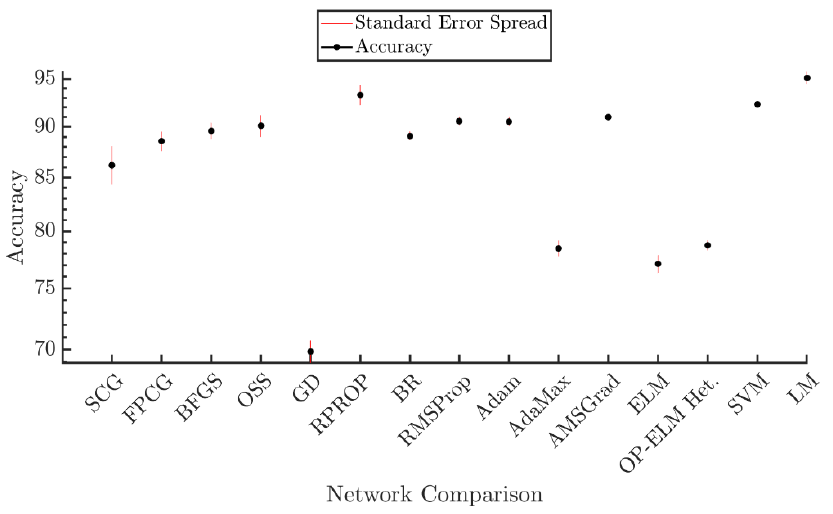
Figure 4. Statistical analysis of the results using an 80% CI. It can be seen from this figure that there is no overlap between the LM ‐ BP algorithm and the other approaches, which is a strong indication that the results from the proposed method are statistically significant.